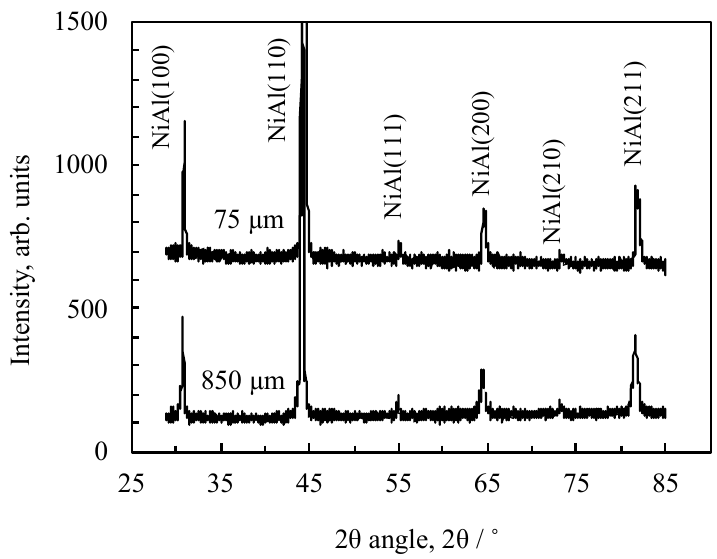
Figure 10. X-ray di ff raction patterns under 75 and over 850 µ m of the classified Al / Ni multilayer Figure 10. X-ray diffraction patterns under 75 and over 850 µm of the classified Al/Ni multilayer powder after the exothermic reaction. powder after the exothermic reaction.